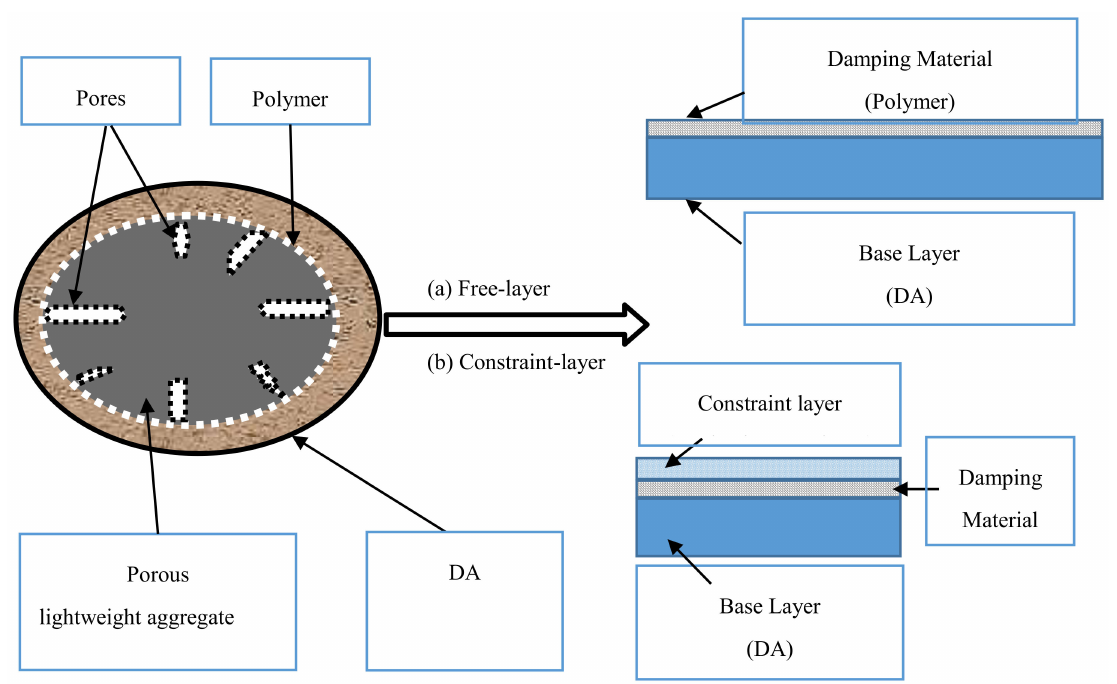
Figure 11. Damping structure among the DA, polymer emulsion, and hydration products of the cement in